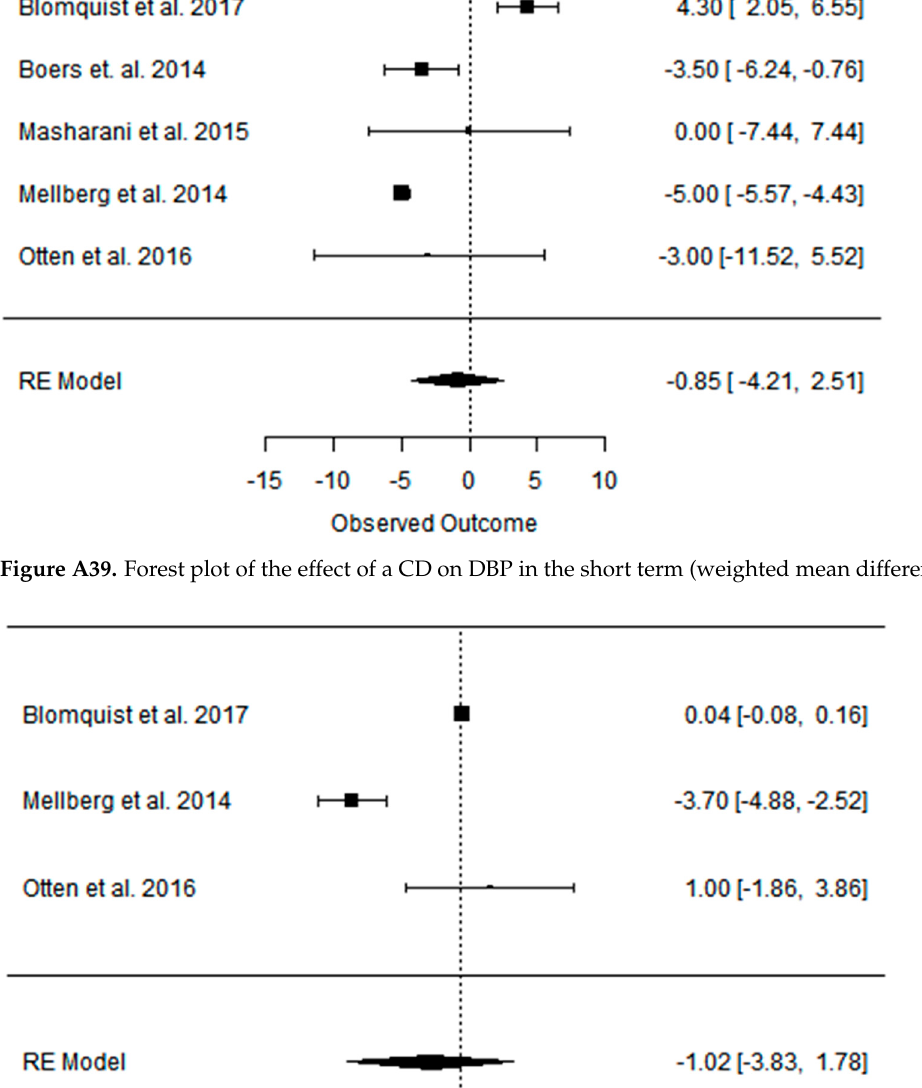
Figure A38. Forest plot of the effect of PD on DBP in the short term (weighted mean difference).